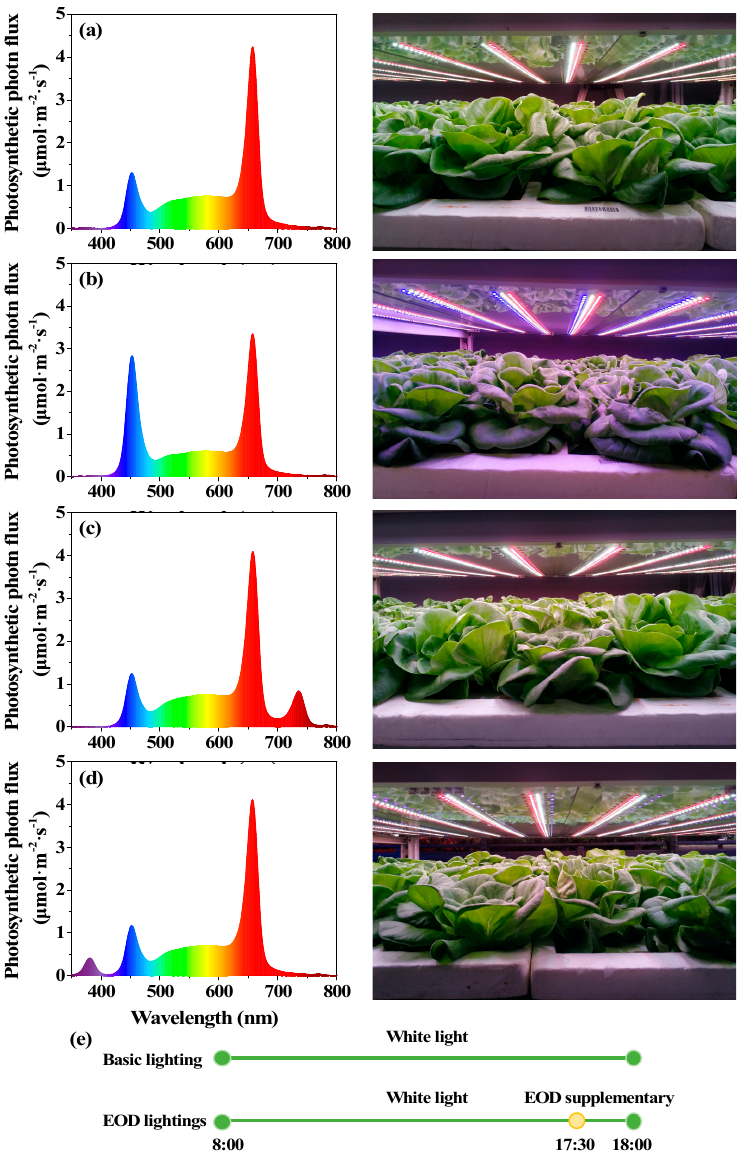
Figure 1. The spectrograms delivered by LEDs. Spectral distributions of ( a ) day-white light (W), ( b ) end-of-day enhanced blue light (EOD-B), ( c ) end-of-day far-red light (EOD-FR), and ( d ) end-of-day ultraviolet-A light (EOD-UV); ( e ) Patterns of end-of-day lighting treatments.